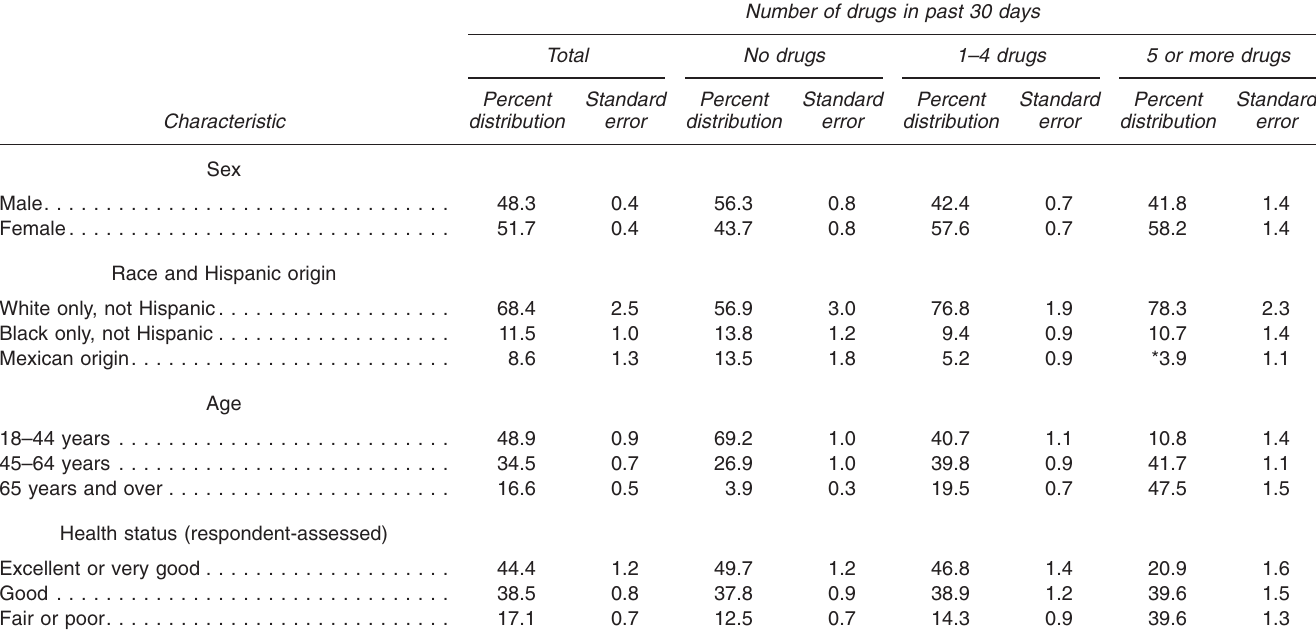
Data table for Figure 22. Number of prescription drugs taken in the past 30 days among adults aged 18 and over, by selected characteristics: United States, 2007–2010 Excel and PowerPoint: